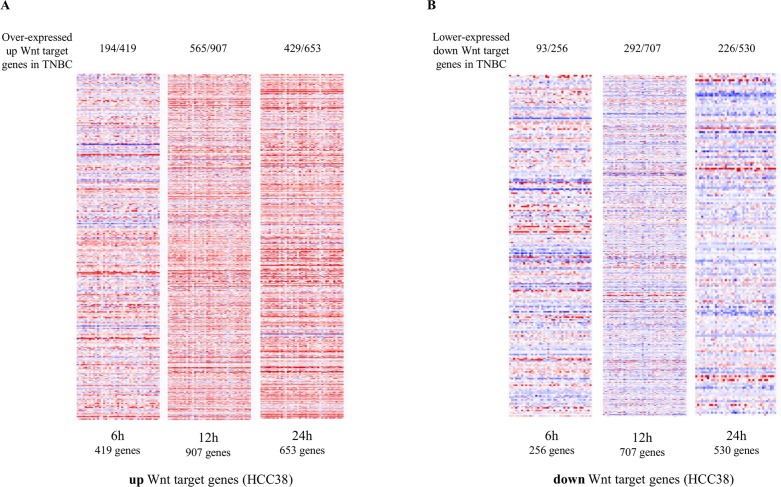
Wnt target genes identified in Wnt3a-stimulated HCC38 cells and their expression in TNBC samples.We identified Wnt target genes that were differentially expressed in HCC38 cells stimulated with Wnt3a (6h, 12h or 24h), and we examined the expression level of up-regulated (A) and down-regulated (B) Wnt target genes in TNBC samples. We restricted the study to the 11262 genes present on both cell line and tumor arrays. We applied a FDR (False Discovery Rate) cut-off of 0.05 and a log-2 fold change threshold of 0. The numbers of up- regulated (A) and down- regulated (B) genes taken into account are indicated at the bottom for each time point (6h, 12h and 24h). The numbers of the Wnt target genes that were more strongly (A) or more poorly (B) expressed in TNBC than in LA samples are indicated on top of the figure. Rows: genes; columns: tumor samples. Red: more strongly expressed genes; blue: more poorly expressed genes. Genes are ordered by gene Entrez ID. The names of the genes are indicated in S8 Fig.